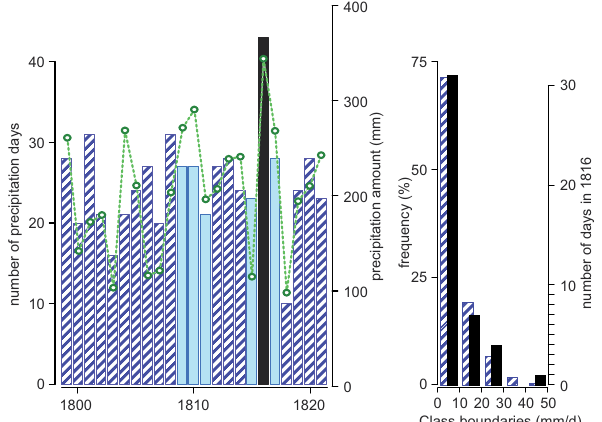
Fig. 4. Left panel: precipitation sums (green line, right scale) and number of rainy days (bars, left scale) in summer (June to August) from 1799–1821. The years that were excluded from the reference period are shown in light blue, 1816 in black. Right panel: his- togram showing the frequency of occurrence (left scale: percent, right scale: number of days for 1816) of precipitation amounts in the summer months (June to August) of 1816 (black) and in the reference period (blue patterned). Note that precipitation amounts < 0.1mm were